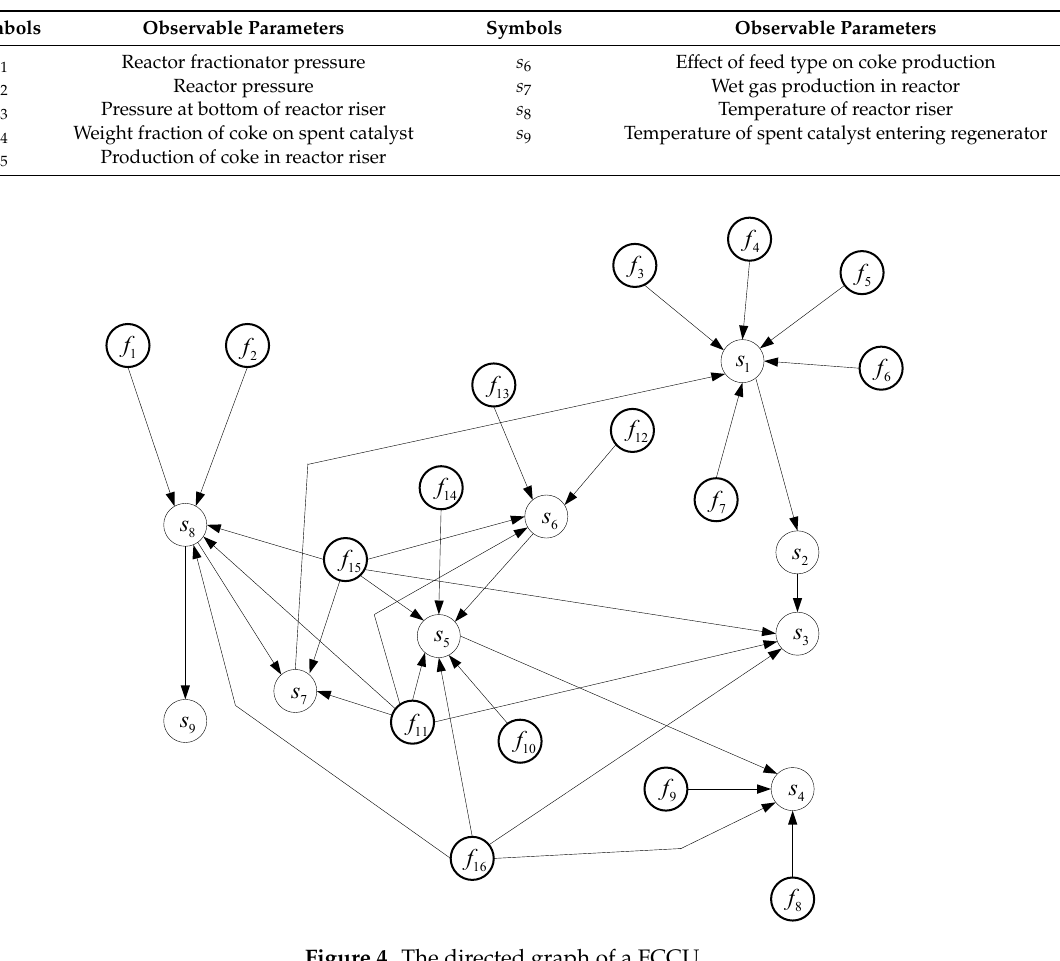
Table 5. The observable parameters of a FCCU.